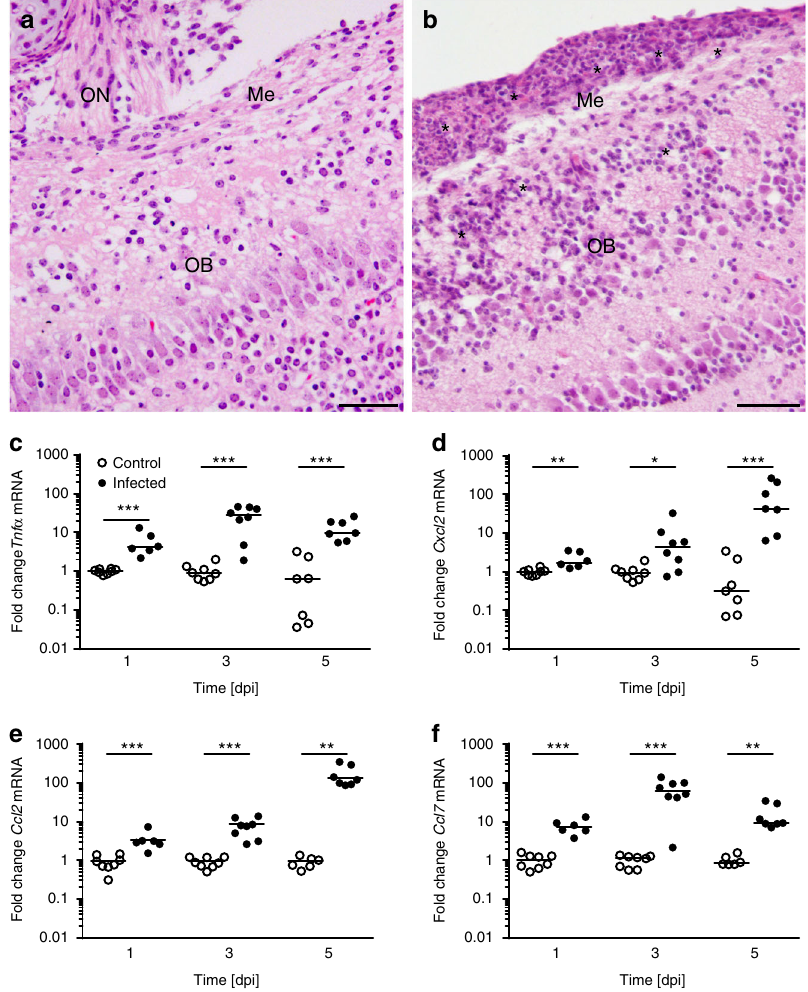
Fig. 5 Intranasal infection with Lm induces in fl ammation in the CNS. One-day-old mice were infected i.n. with 1 × 10 4 CFU Lm or left untreated. Tissue